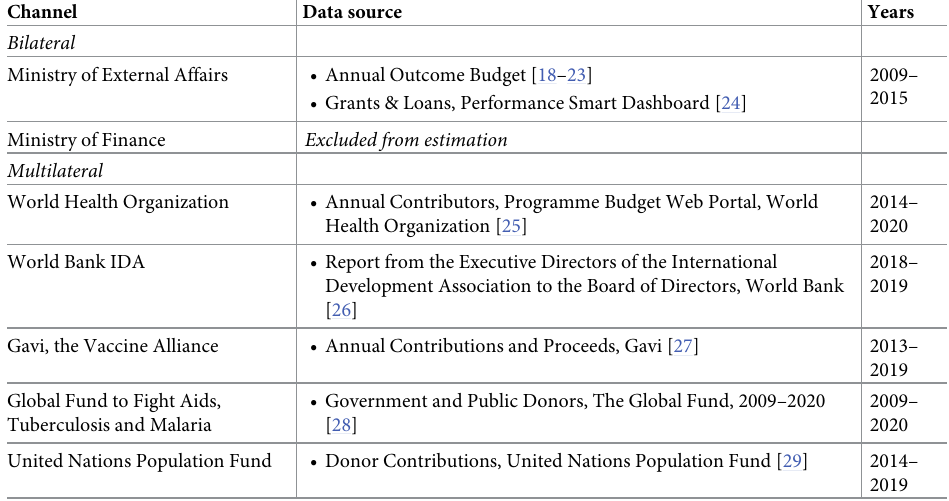
Table 1. Data sources used for retrospective estimation of DAH from